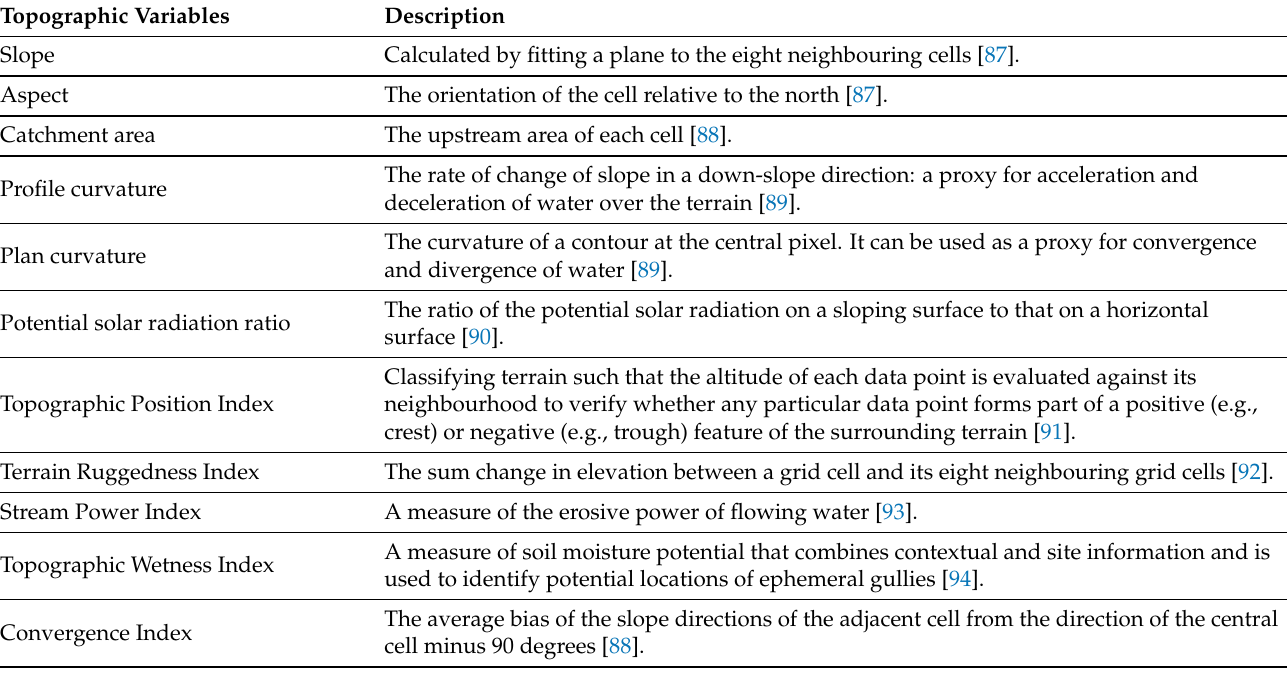
Table A1. Topographic attributes derived from DTM using ALS data at a spatial resolution of 20m for each site.